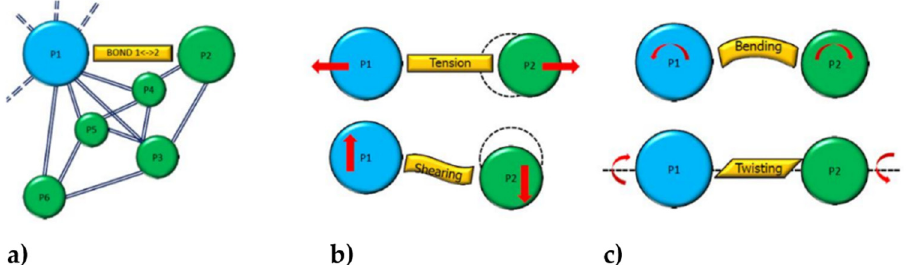
Figure 5. Schematic drawing of the possible bonding of particle P1 to its neighbors P2 to P6: ( a ) using intermolecular bonds, ( b ) using tensile and shear stresses, ( c ) using torsional and bending stresses [26].